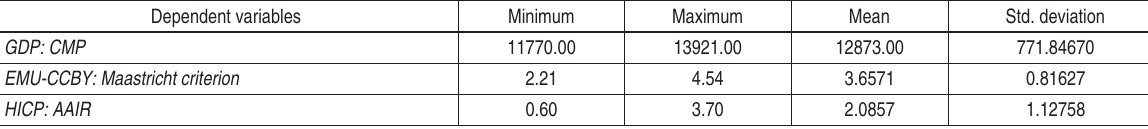
Table 2. The statistical descriptive analysis of dependent variables